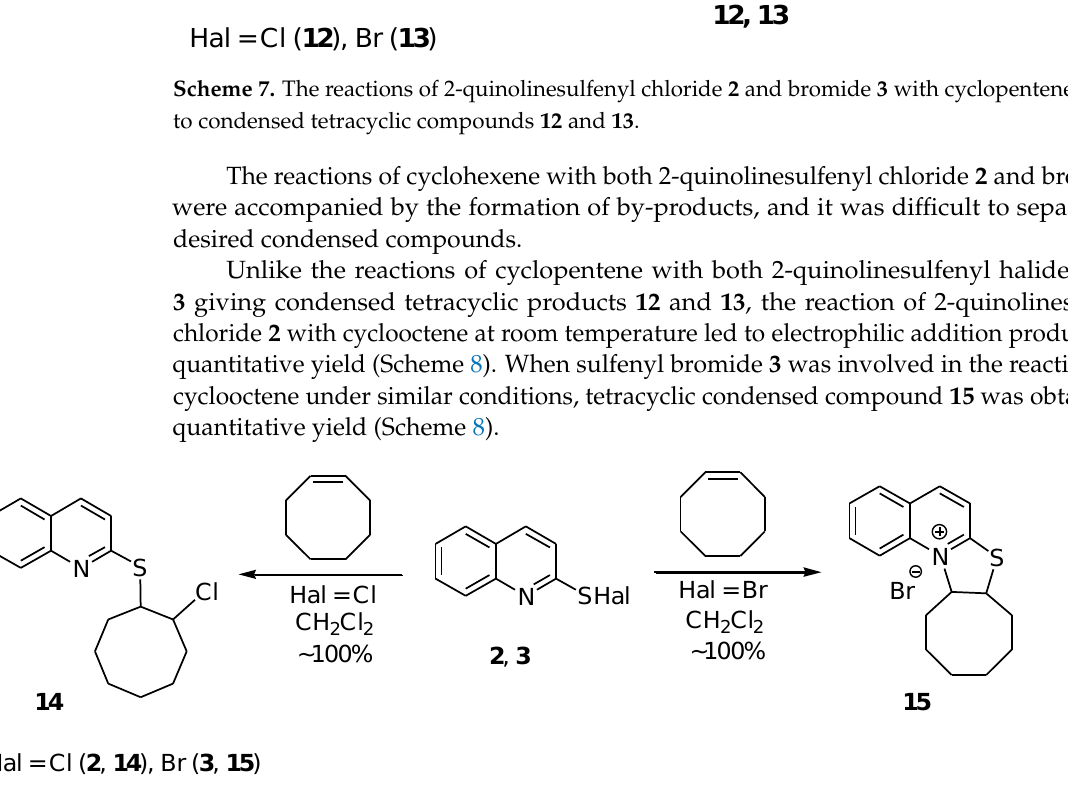
Scheme 8. The reactions of 2-quinolinesulfenyl chloride 2 and bromide 3 with cyclooctene affording compounds 14 and 15 .